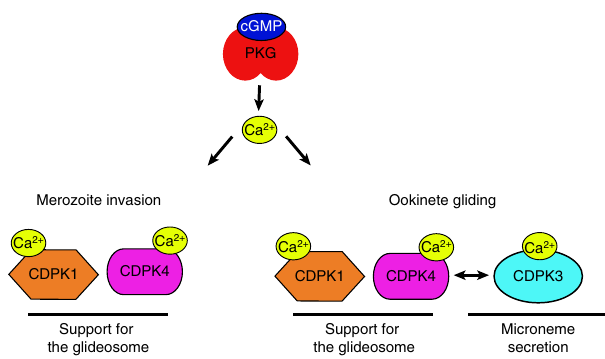
Fig. 6 Schematic representation of the CDPK networks downstream of PKG-mediated calcium signals. PKG acts as a stage-transcending calcium regulator that activates multiple CDPKs with stage-speci fi c functions. In merozoites, calcium activates both CDPK4 and 1 to support the activity of the acto-myosin motor. In ookinetes, PKG-dependent calcium signals are required for ef fi cient gliding through CDPK4 and 1 activation and microneme secretion via CDPK3 regulation. Under physiological activation of PKG, CDPK1 and CDPK4 may functionally complement each other to sustain the acto-myosin motor function, while hyperactivation of PKG by chemical or genetic inhibition of phosphodiesterase or adaptation to gene deletion may allow further complementation by CDPK3 in ookinetes 24